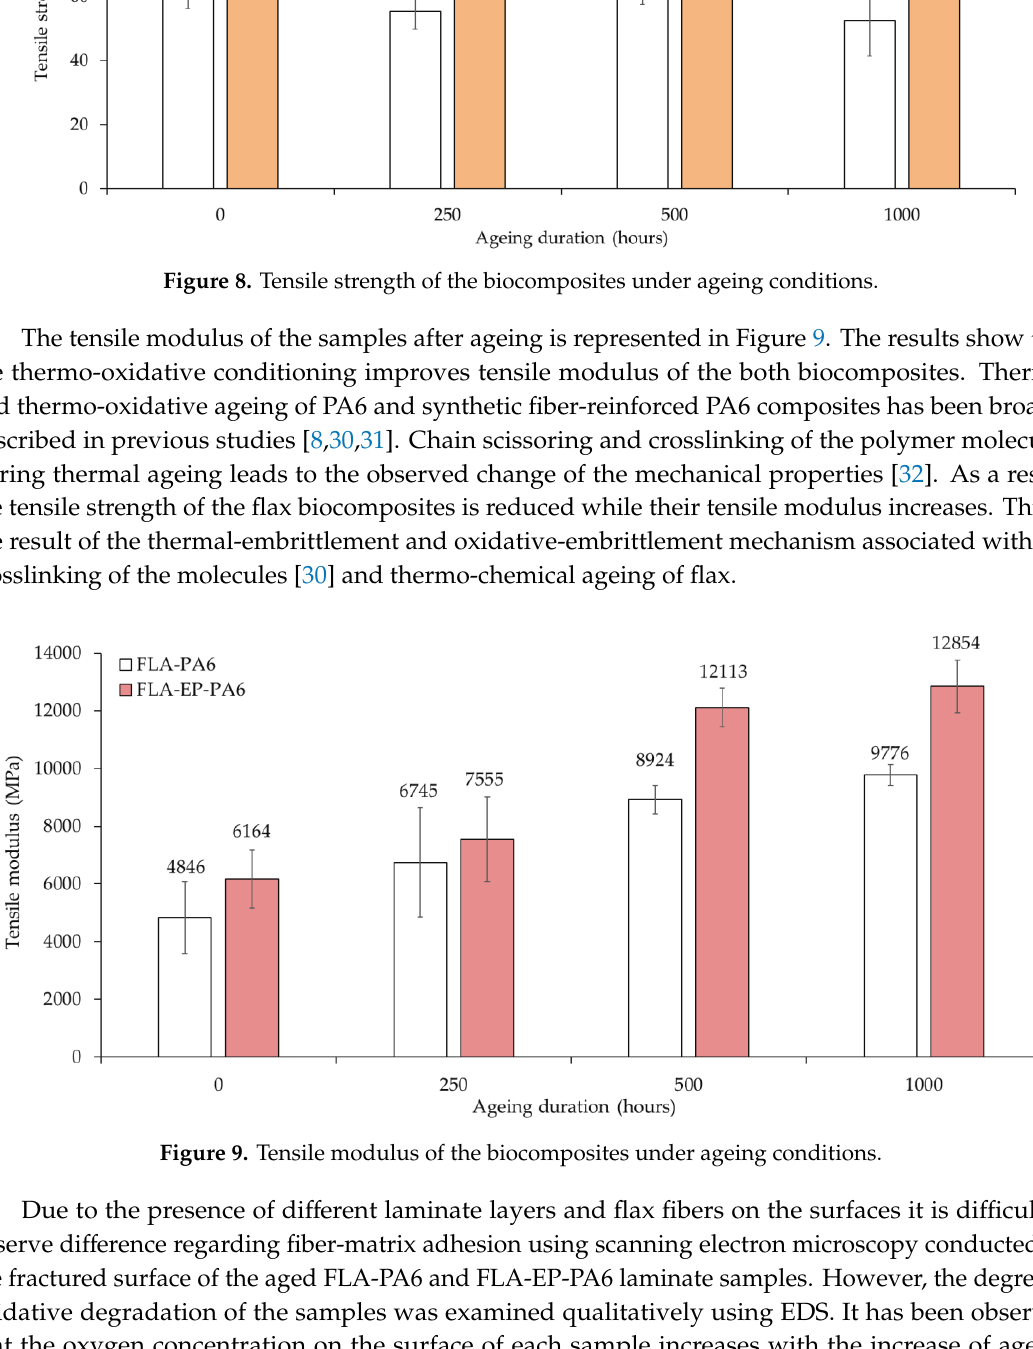
Figure 8. Tensile strength of the biocomposites under ageing conditions.